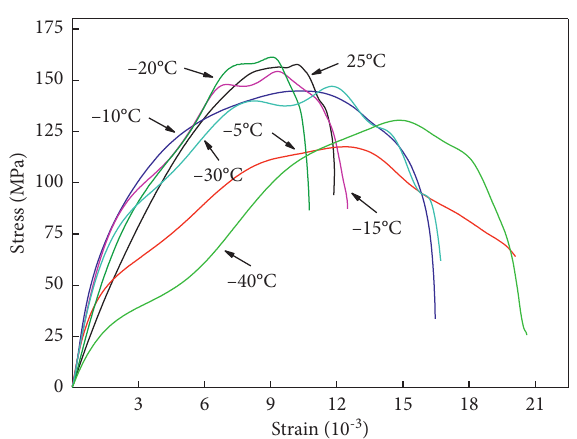
Figure 10: Stress-strain curves of saturated marble under different temperatures. Table 1: Peak strengths of saturated marble under different